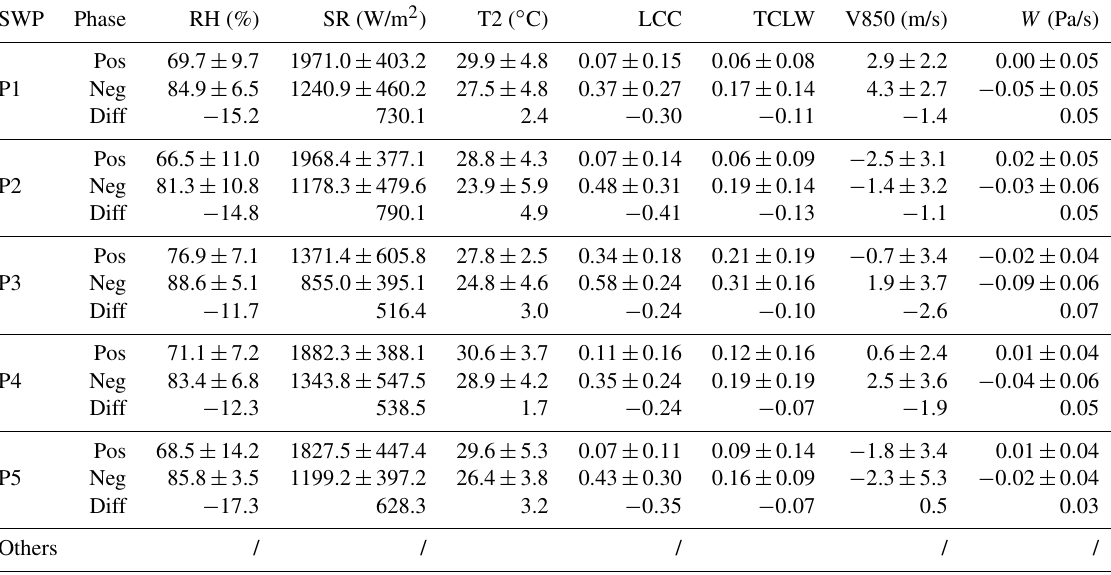
Table 3. Regional mean ± the standard error of meteorological factors in Pos and Neg phases and their difference (Diff) under each SWP pattern.